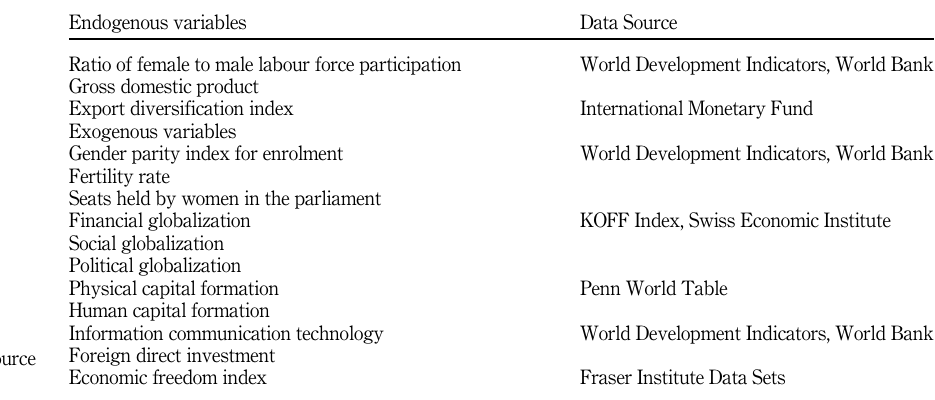
Table A1. Description of variables and source of